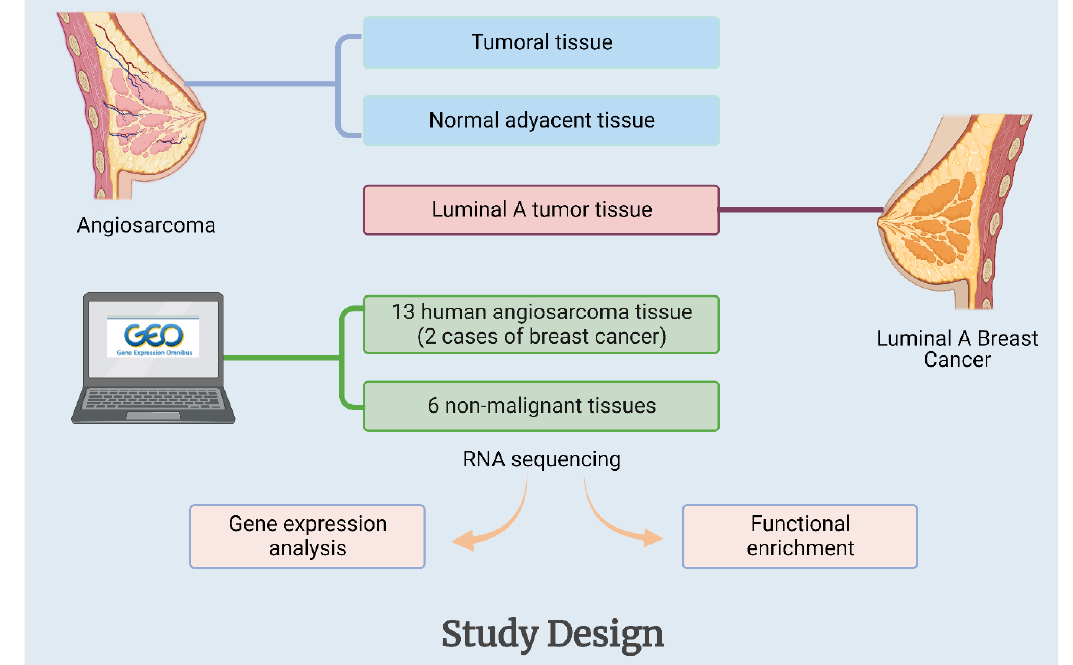
Figure 1. General outline of this